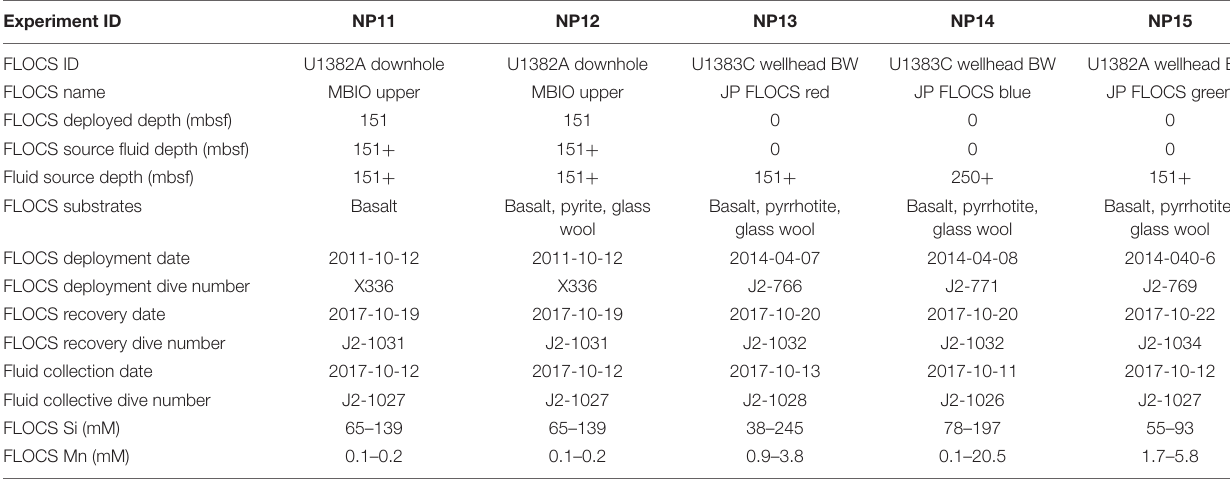
TABLE 1 | Summary of mineral colonization experiments (i.e., FLOCS) and inoculating fluids used in the poised potential experiments, including deployment and recovery information about the FLOCS experiments and the source fluids used as inoculum and/or media, and the concentrations of dissolved silica and manganese within the FLOCS at the time of